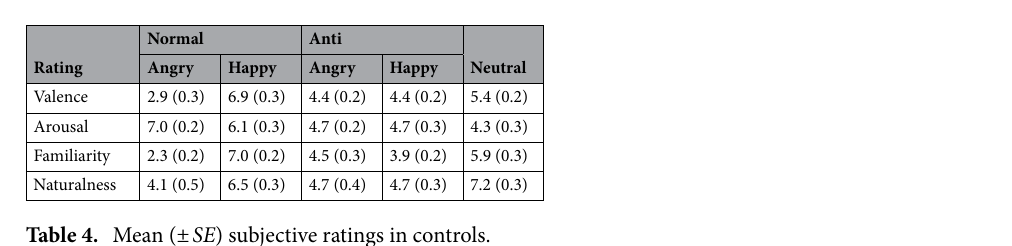
familiar than anti-happy ones. For the naturalness ratings, the main effect of emotion ( F (1,22) = 6.40, p = 0.019, η 2 p = 0.225) and the stimulus type × emotion interaction ( F (1,22) = 22.35, p < 0.001, η 2 p = 0.504) were significant. Follow-up analyses of the interaction showed significant simple main effects of stimulus type on both anger and happiness ( F (1,44) > 6.84, p < 0.05); i.e., naturalness ratings were higher for anti-angry than normal angry expressions, and for normal happy than anti-happy expressions. The subjective ratings of the controls are shown in Table 4. The rating data from the controls were analyzed by two-way ANOVA using stimulus type and emotion as factors, like that described for the patients. For the valence ratings, the main effect of emotion ( F (1,22) = 81.77, p < 0.001, η 2 p = 0.788) and the interaction between stimulus type and emotion ( F (1,22) = 63.97, p < 0.001, η 2 p = 0.744) were significant. Follow-up analyses happy expressions, respectively, compared with their corresponding anti-expressions. For the arousal ratings,